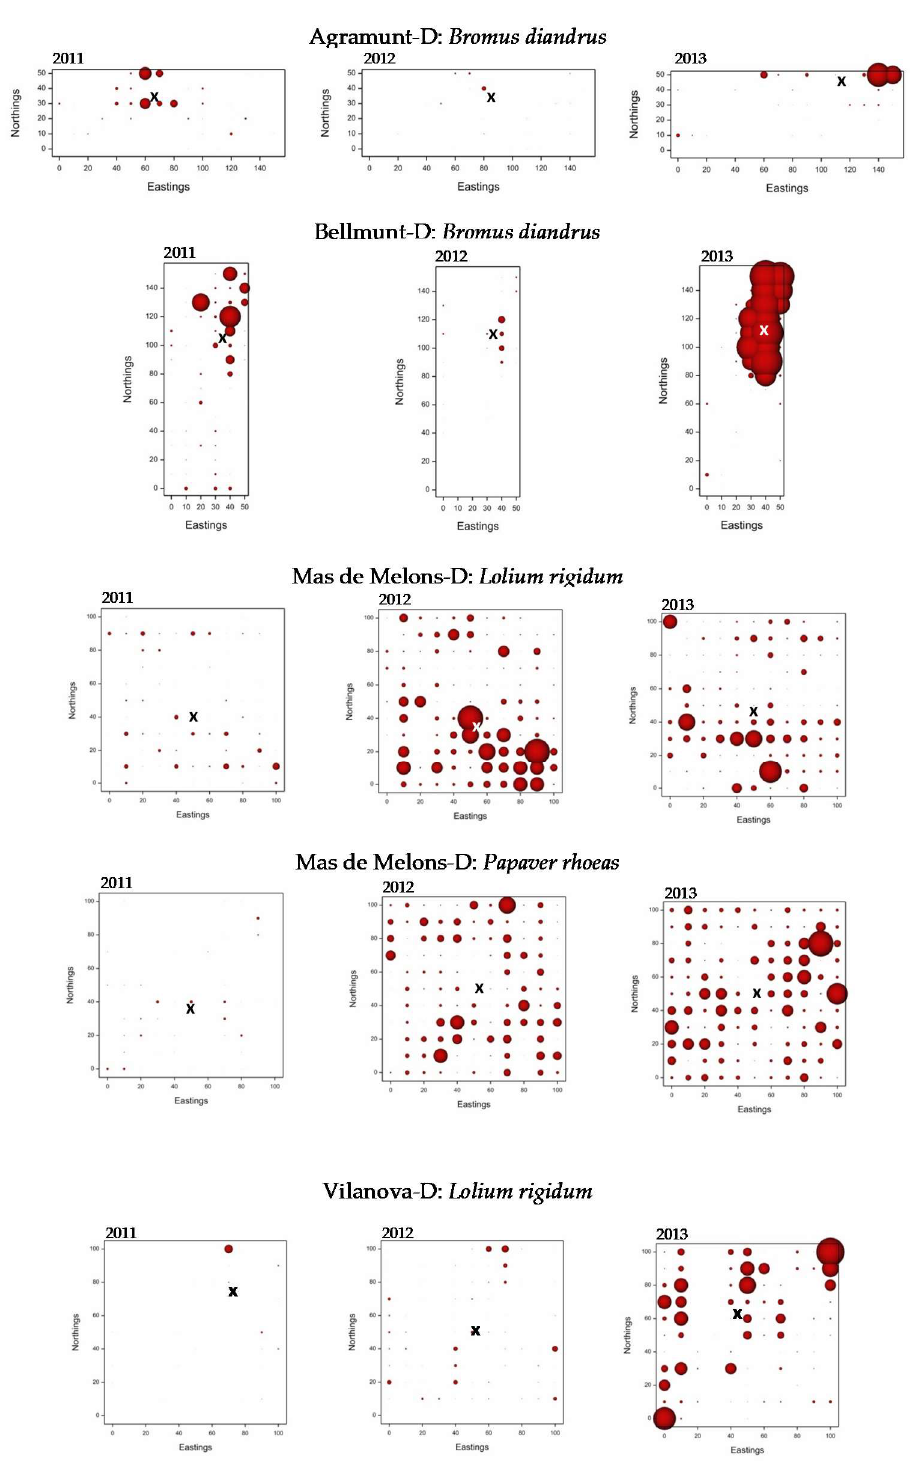
Figure 2. Maps of weed cover (%) with centers of gravity ( x ) in the fields with direct drilling (D). Circle sizes are proportional to the percentages of weed cover: 100% 50% 25% 10%.